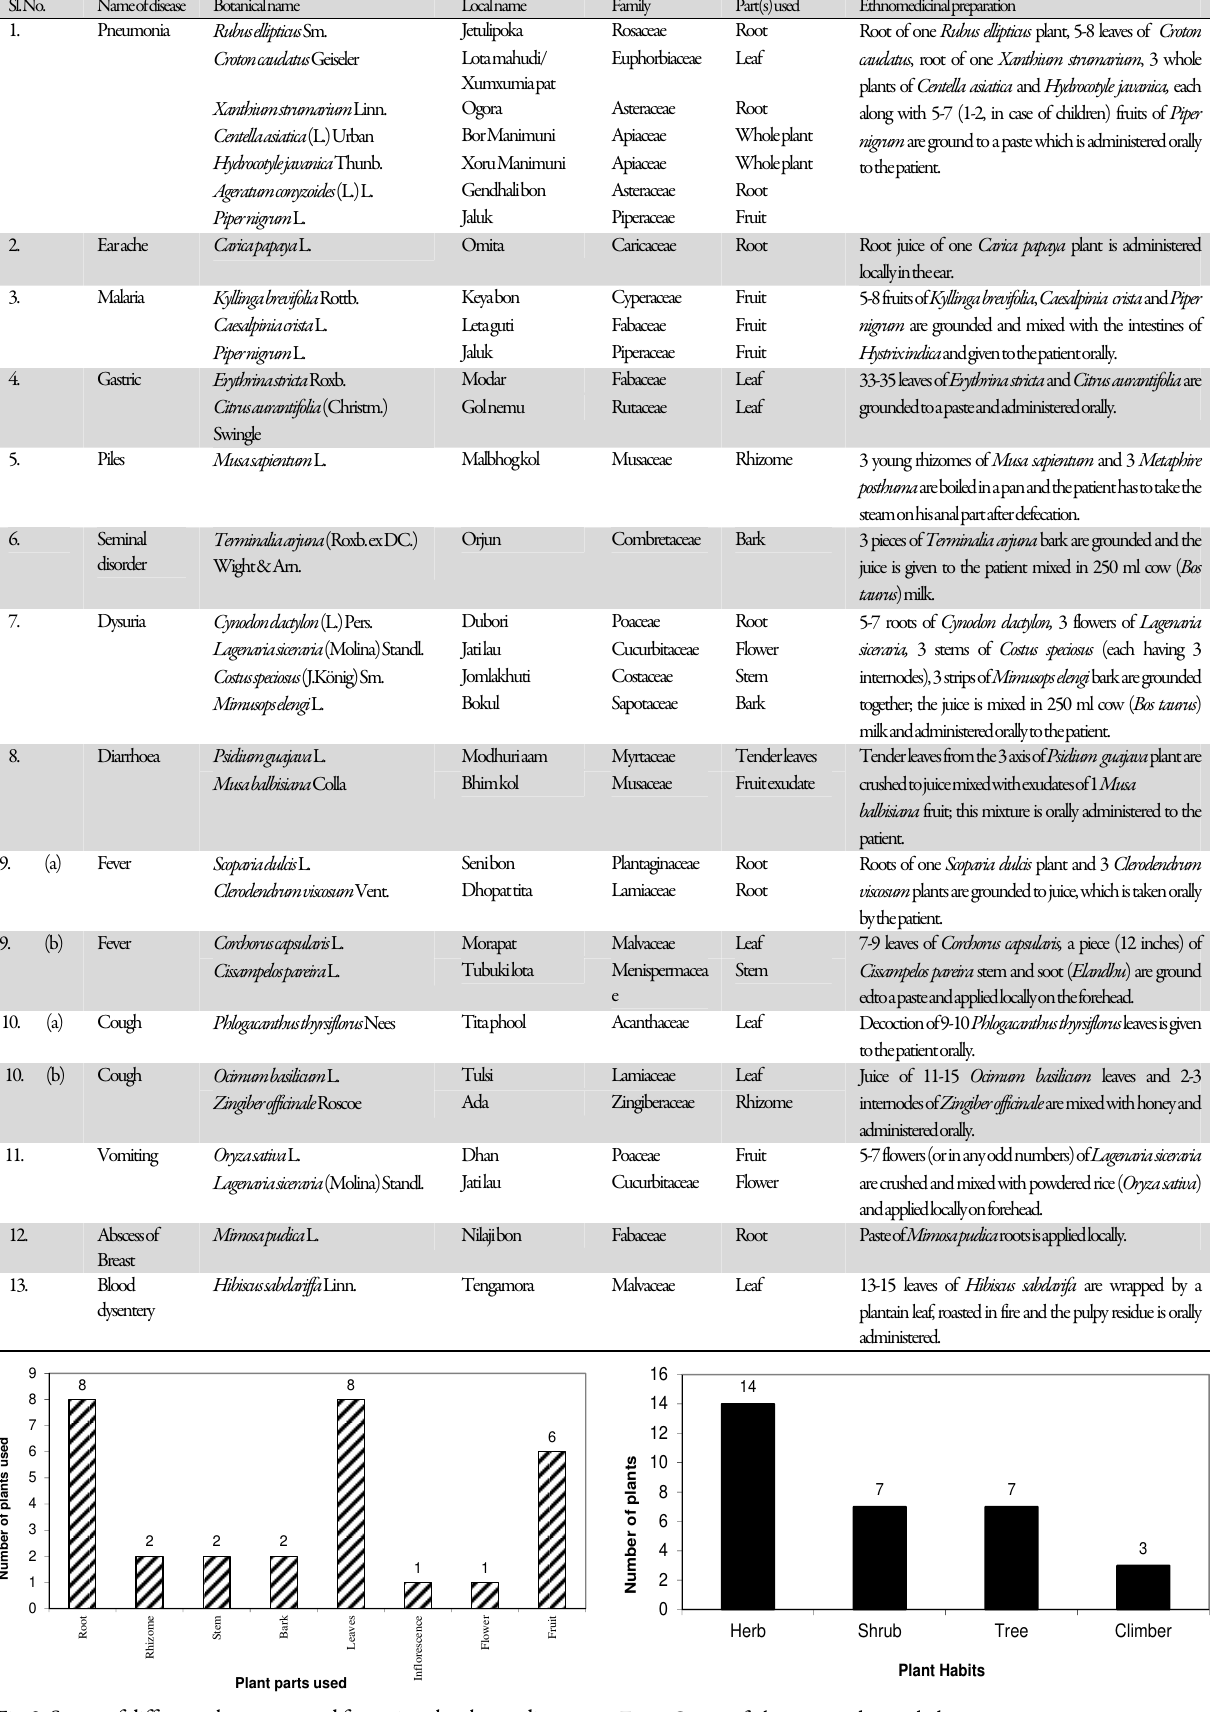
Fig. 2. Status of different plant parts used for various local remedies Fig. 3. Status of plants according to